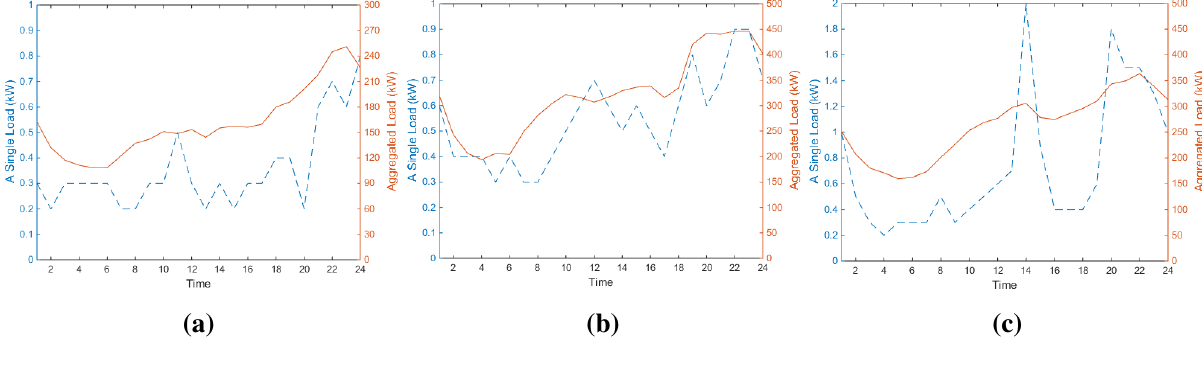
Figure 3. Daily load profile for apartment residents across 24 h period on 1 August 2013: A sample of single residential customer load (dashed-lines) and aggregated load (solid-lines). ( a ) apartment complex A; ( b ) apartment complex B; and ( c ) apartment complex C.